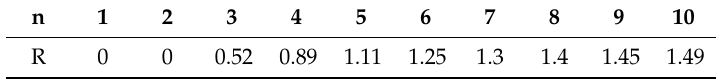
Table 6. The order of the matrix (n) and the equivalent random index